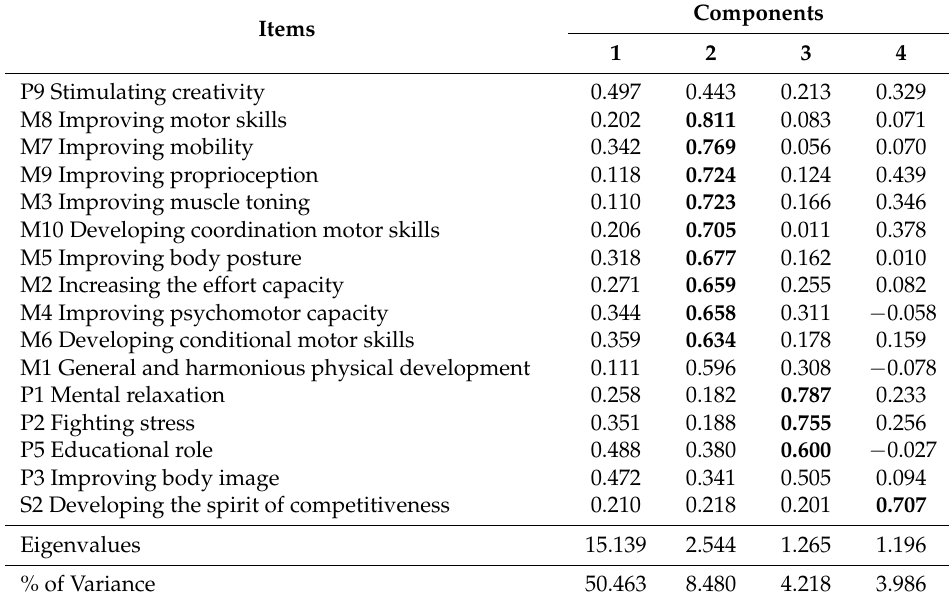
Table 5. Statistical correlation between the parts of the questionnaire about the benefits of practicing recreational figure skating.